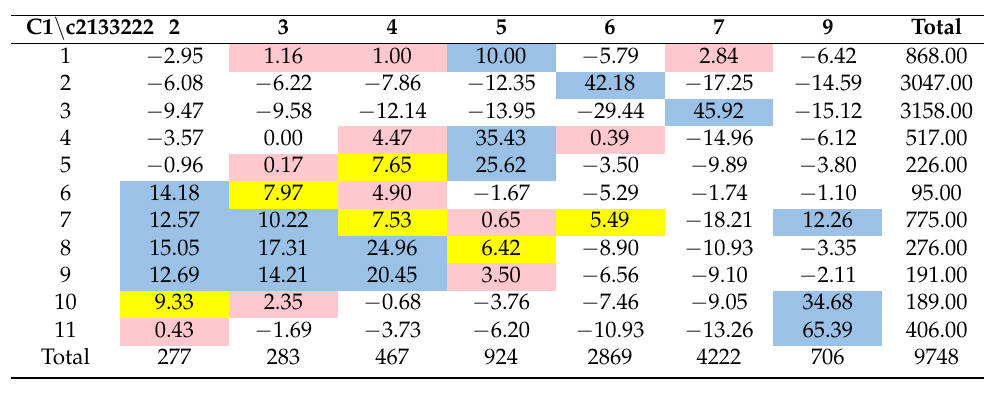
Table A5. Theoretical frequencies AFWW 2018 (C1 \ c2133222).